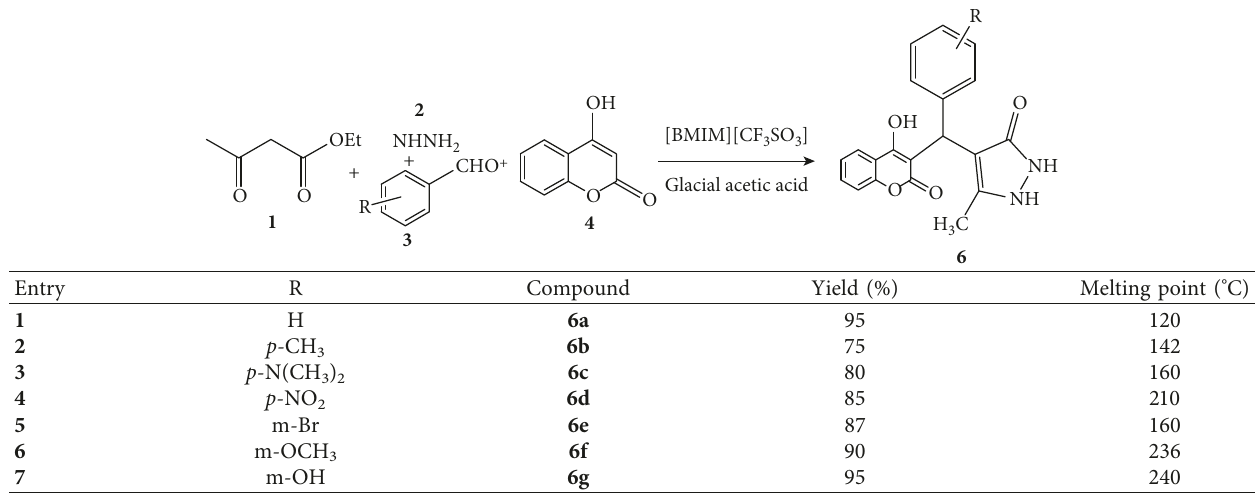
Table 3: Chemical yields and physical properties of coumarins derivatives 6a – 6g .